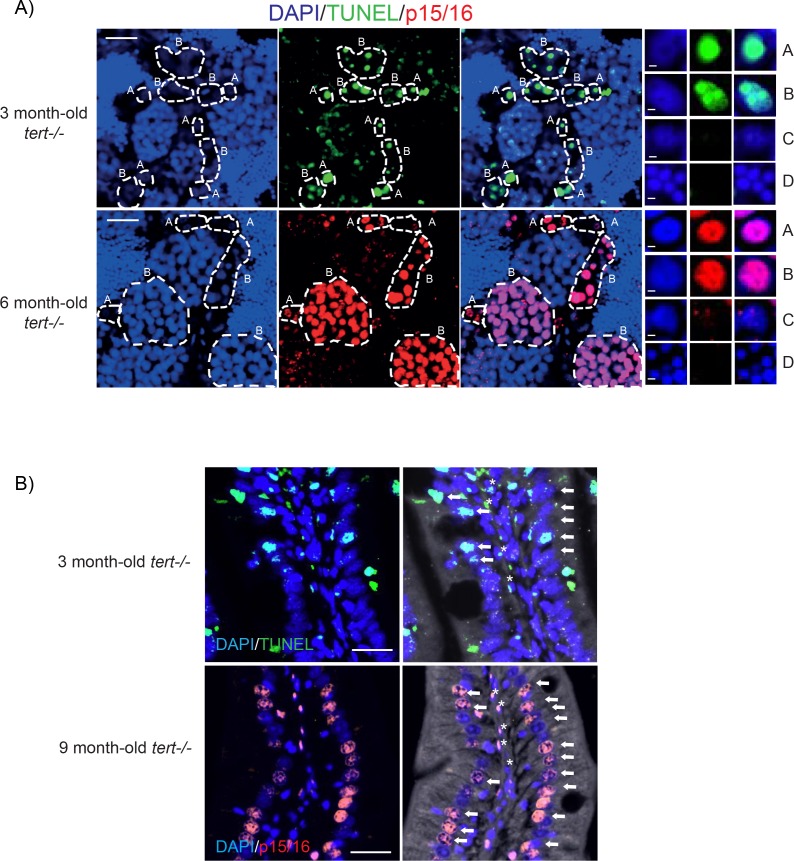
Apoptosis and senescence cell fate is present in the same cell types of gut and testis.(A) Representative immunofluorescence images of apoptosis (TUNEL) or senescence (p15/16 IF) of testis from 3 month or 6-month-old tert-/- fish. Dashed lines delimitate cysts containing spermatogonia A (A) or B (B); scale bar: 20 µm. Right panel depicts examples of every cell type identified (A: spermatogonia A; B: spermatogonia B; C: spermatocytes; D: spermatids/spermatozoids); scale bar: 2 µm. Cell types were identified by their nuclear size and morphology, presence and number of nucleoli, and number of cells per cyst. B) Representative immunofluorescence images of apoptosis (TUNEL) or senescence (p15/16) of gut from 3 month or 9-month-old tert-/- fish. Arrows represent enterocyte cells; asterisks show blood cells). Cell types were identified by cell morphology and location. Scale bars: 20 µm.